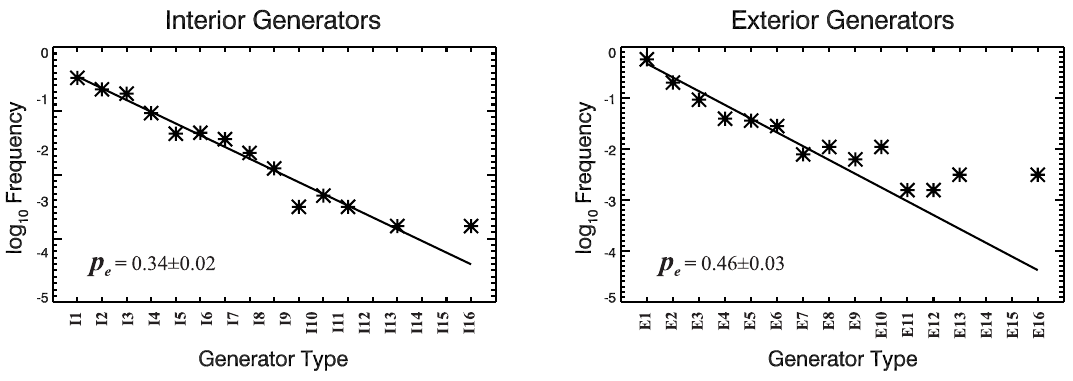
Fig. 5. Estimated parameters for a geometric distribution describing generators in Walnut Gulch, AZ.